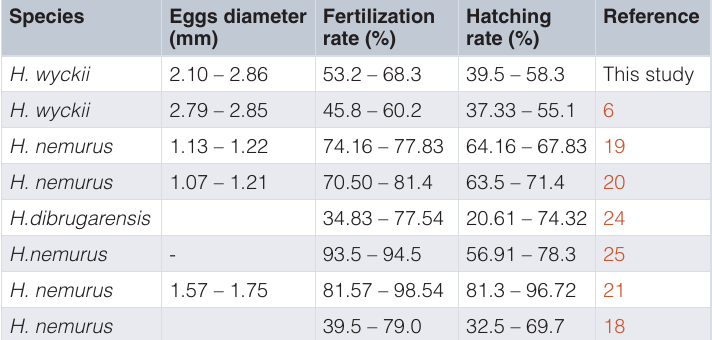
Table 5. Summary of the egg diameter, fertilization and hatching rate of H.wyckii , with respect to those reported for H.nemurus and H.dibrugarensis